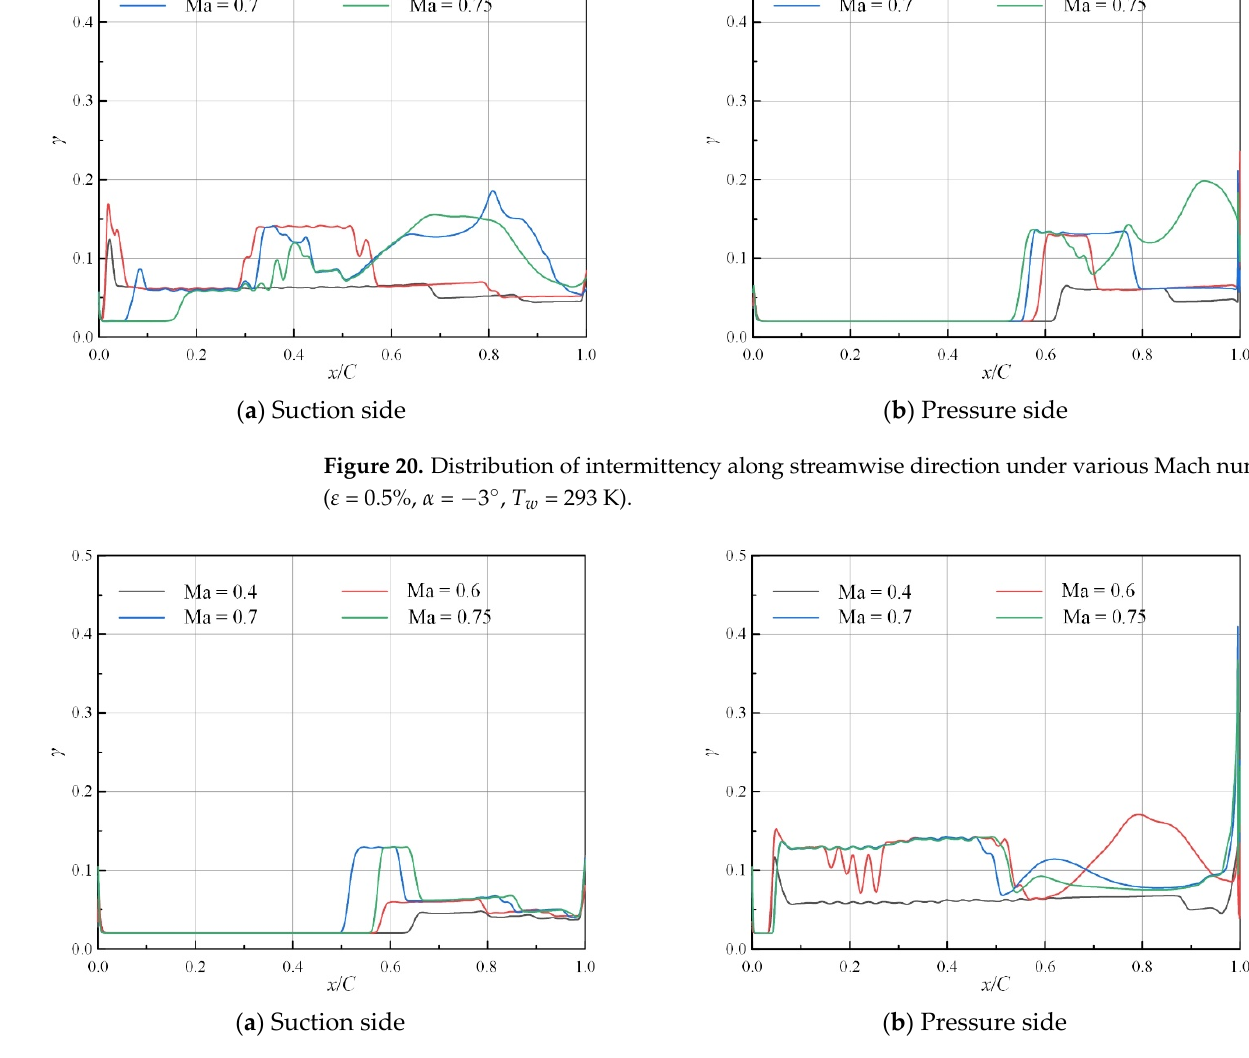
Figure 21. Distribution of intermittency along streamwise direction under various Mach numbers ( ε = 0.5%, α = 3°, T w = 293 K).